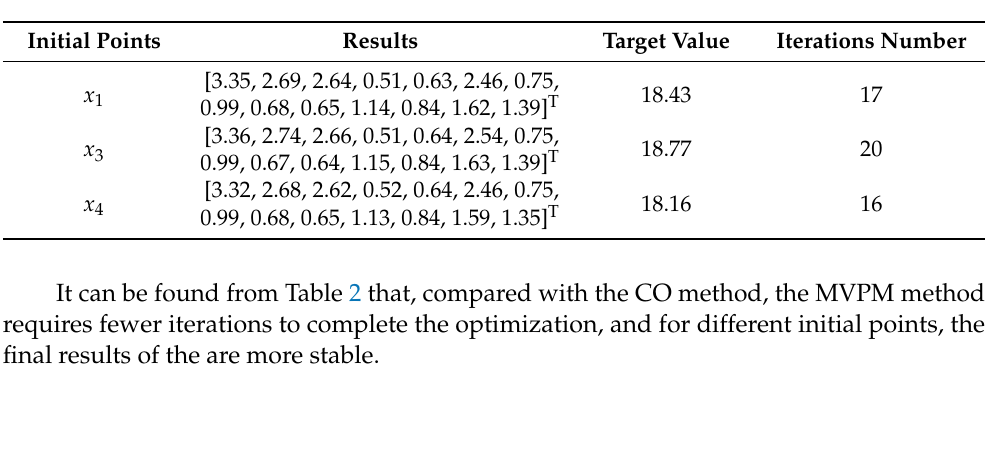
Table 2. The results of the